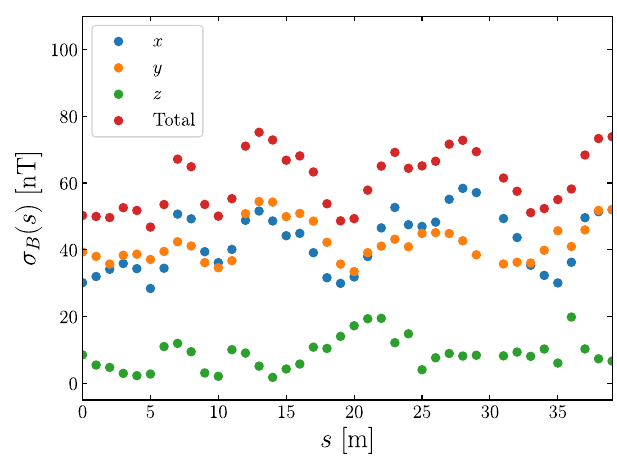
FIG. 5. Standard deviation of the magnetic field σ B ð s Þ in the x direction (blue), y direction (orange), z direction (green) and total (red) vs location s